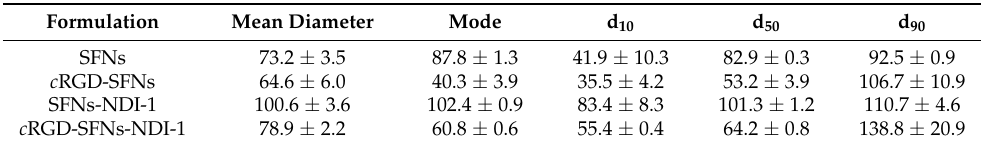
Table 2. Size and size distribution of all the nanoparticles prepared. Data are reported in nm as mean value ± standard deviation, n = 5 independent measurements.